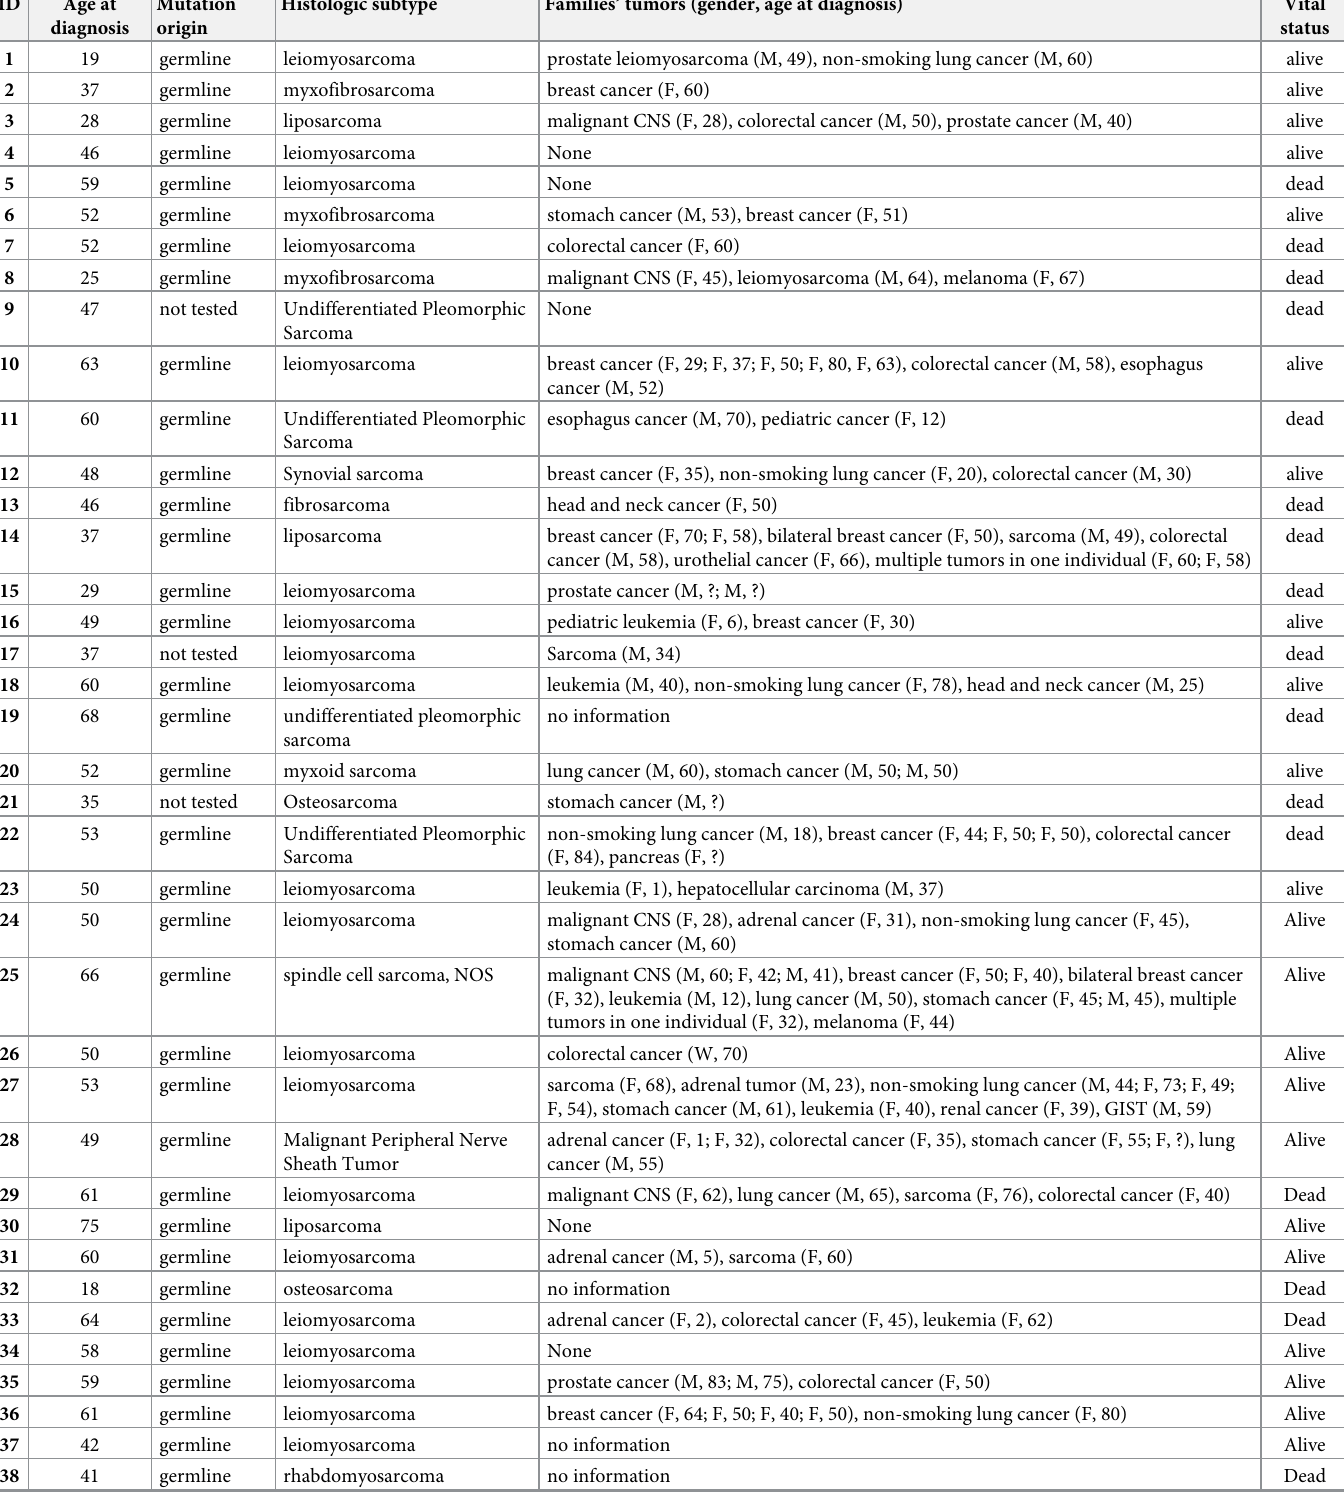
Table 2. Characteristics of patients with p.Arg337His